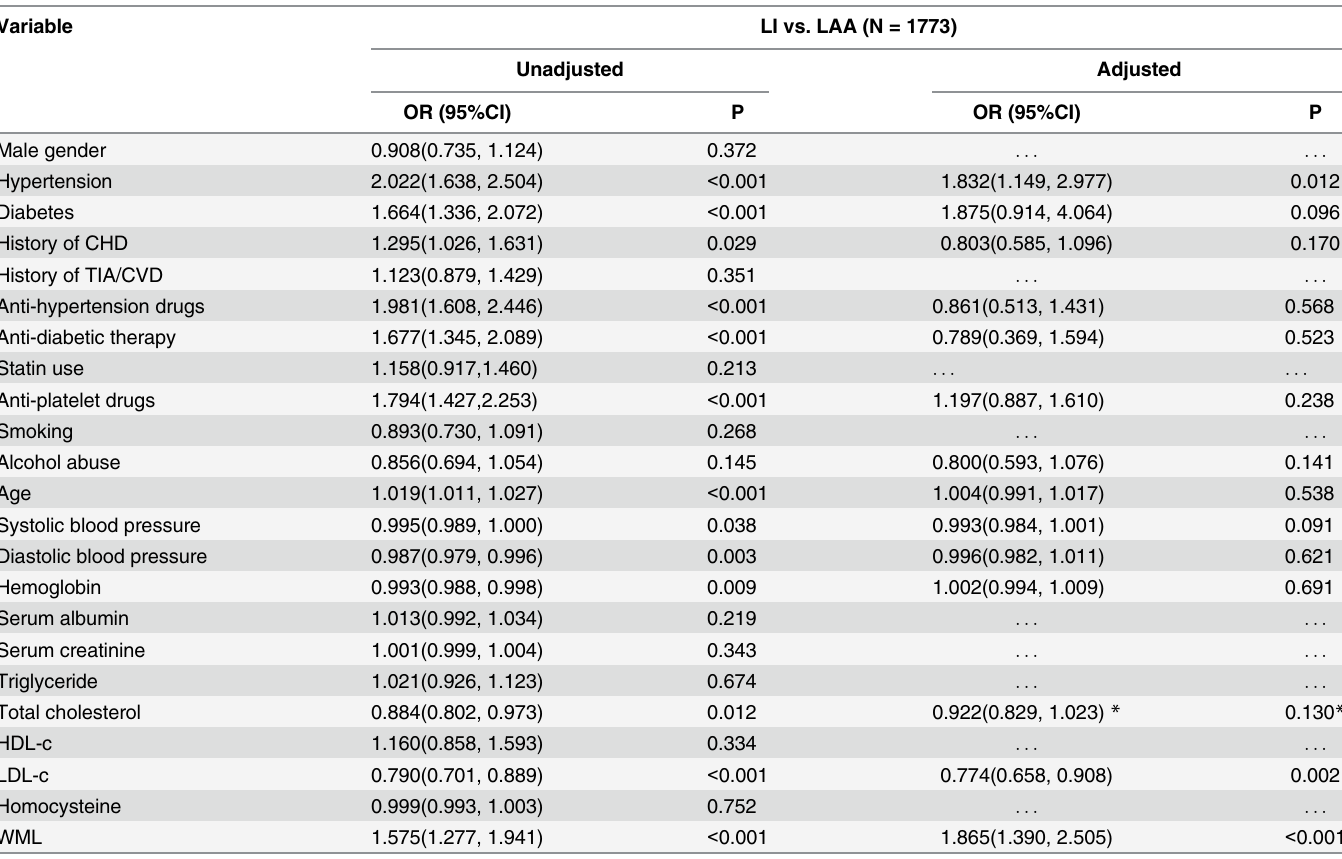
Table 3. Results of univariate and multivariate logistic analysis: clinical characteristics associated with different stroke subtypes (LI patients vs. LAA